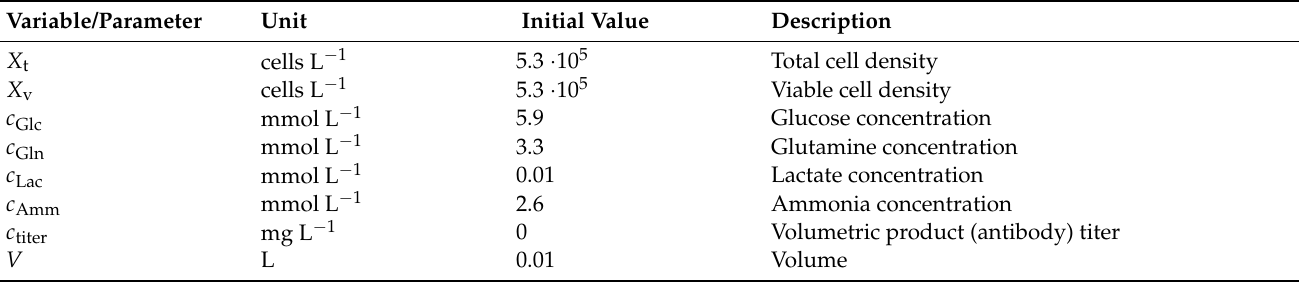
Table A1. Modeled variables and model parameters included in the underlying model (symbols, units and descriptions).